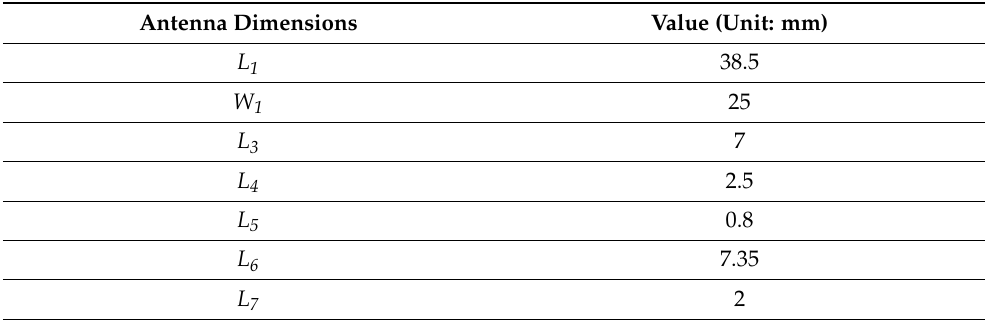
Table 1. Detailed dimensions of single-element combined Minkowski–Sierpinski carpet fractal antenna structure. Antenna